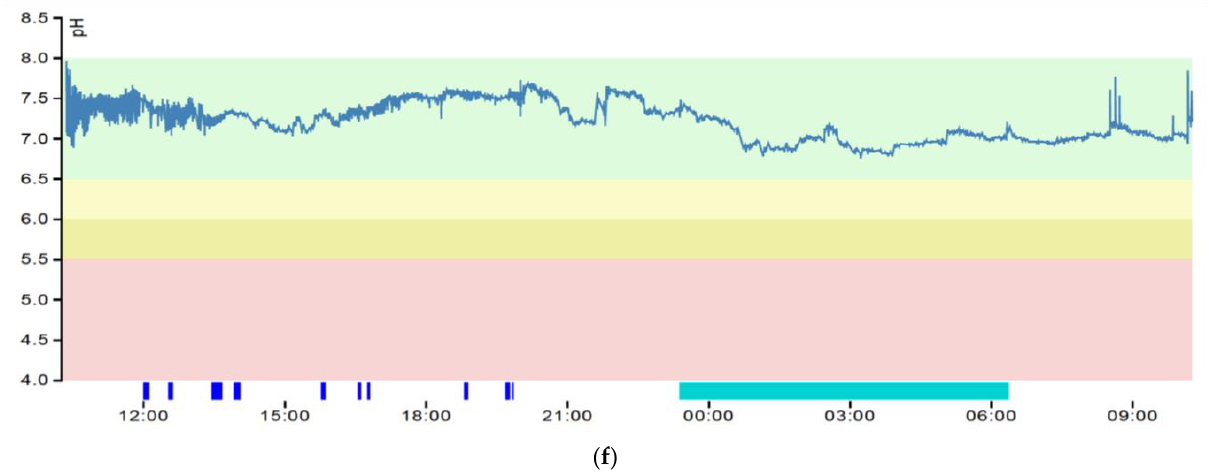
Figure 1. ( a ) Severe laryngopharyngeal reflux—blue bar = mealtimes; green bar = supine position. ( b ) Moderate laryngopharyngeal reflux—blue bar = mealtimes; green bar = supine position. ( c ) Mild laryngopharyngeal reflux—blue bar = mealtimes; green bar = supine position. ( d ) Neutral laryngopharyngeal reflux—blue bar = mealtimes; green bar = supine position. ( e ) Alkaline laryngopharyngeal reflux—blue bar = mealtimes; green bar = supine position. ( f ) No laryngopharyngeal reflux—blue bar = mealtimes; green bar = supine position.